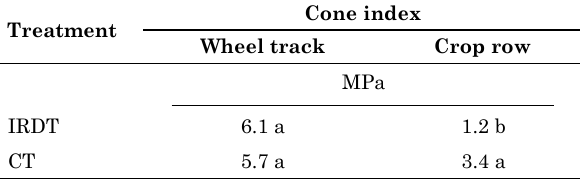
table 3. Soil cone index in treatments: in-row deep tillage (irdt) and Conventional tillage (Ct), at different sampling locations, after soil tillage treatment